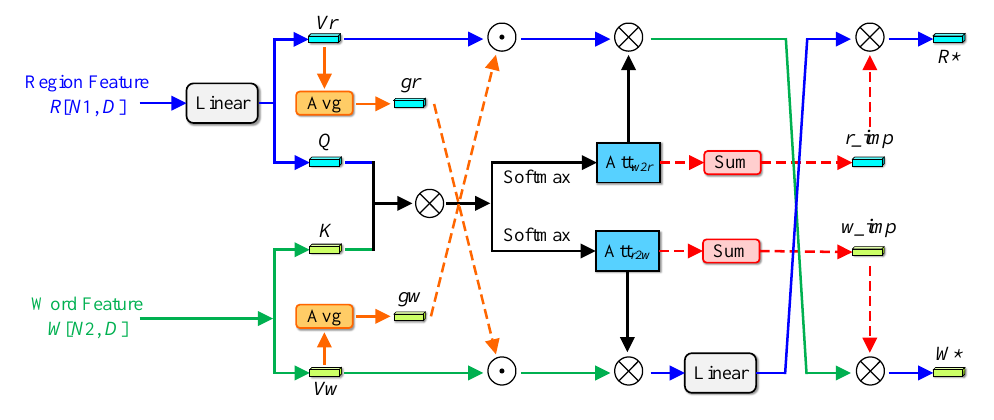
Figure 2. The co-attention (CA) block used in PAM, with the guard gates (orange marked) and importance rectification (red